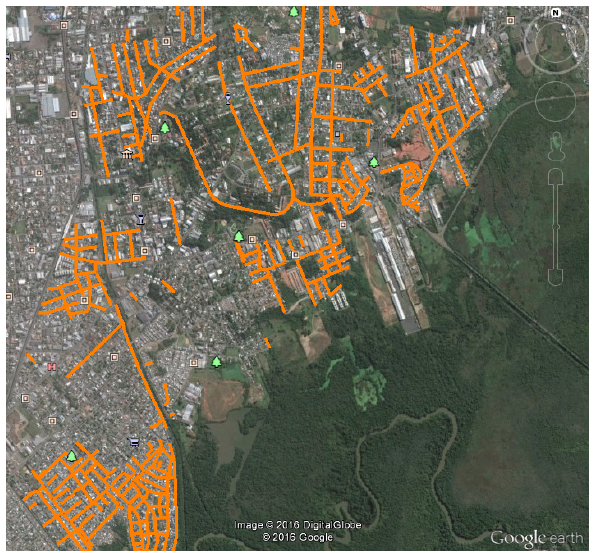
Figure 4. Roads with value “unclassified” for the key “highway” in an area nearby Porto Alegre, Brazil (satellite map by Google Earth with images © Digital Globe) There are currently 34.3 million roads in the OSM dataset classified as “residential” or as “living_street”. 9.0 million